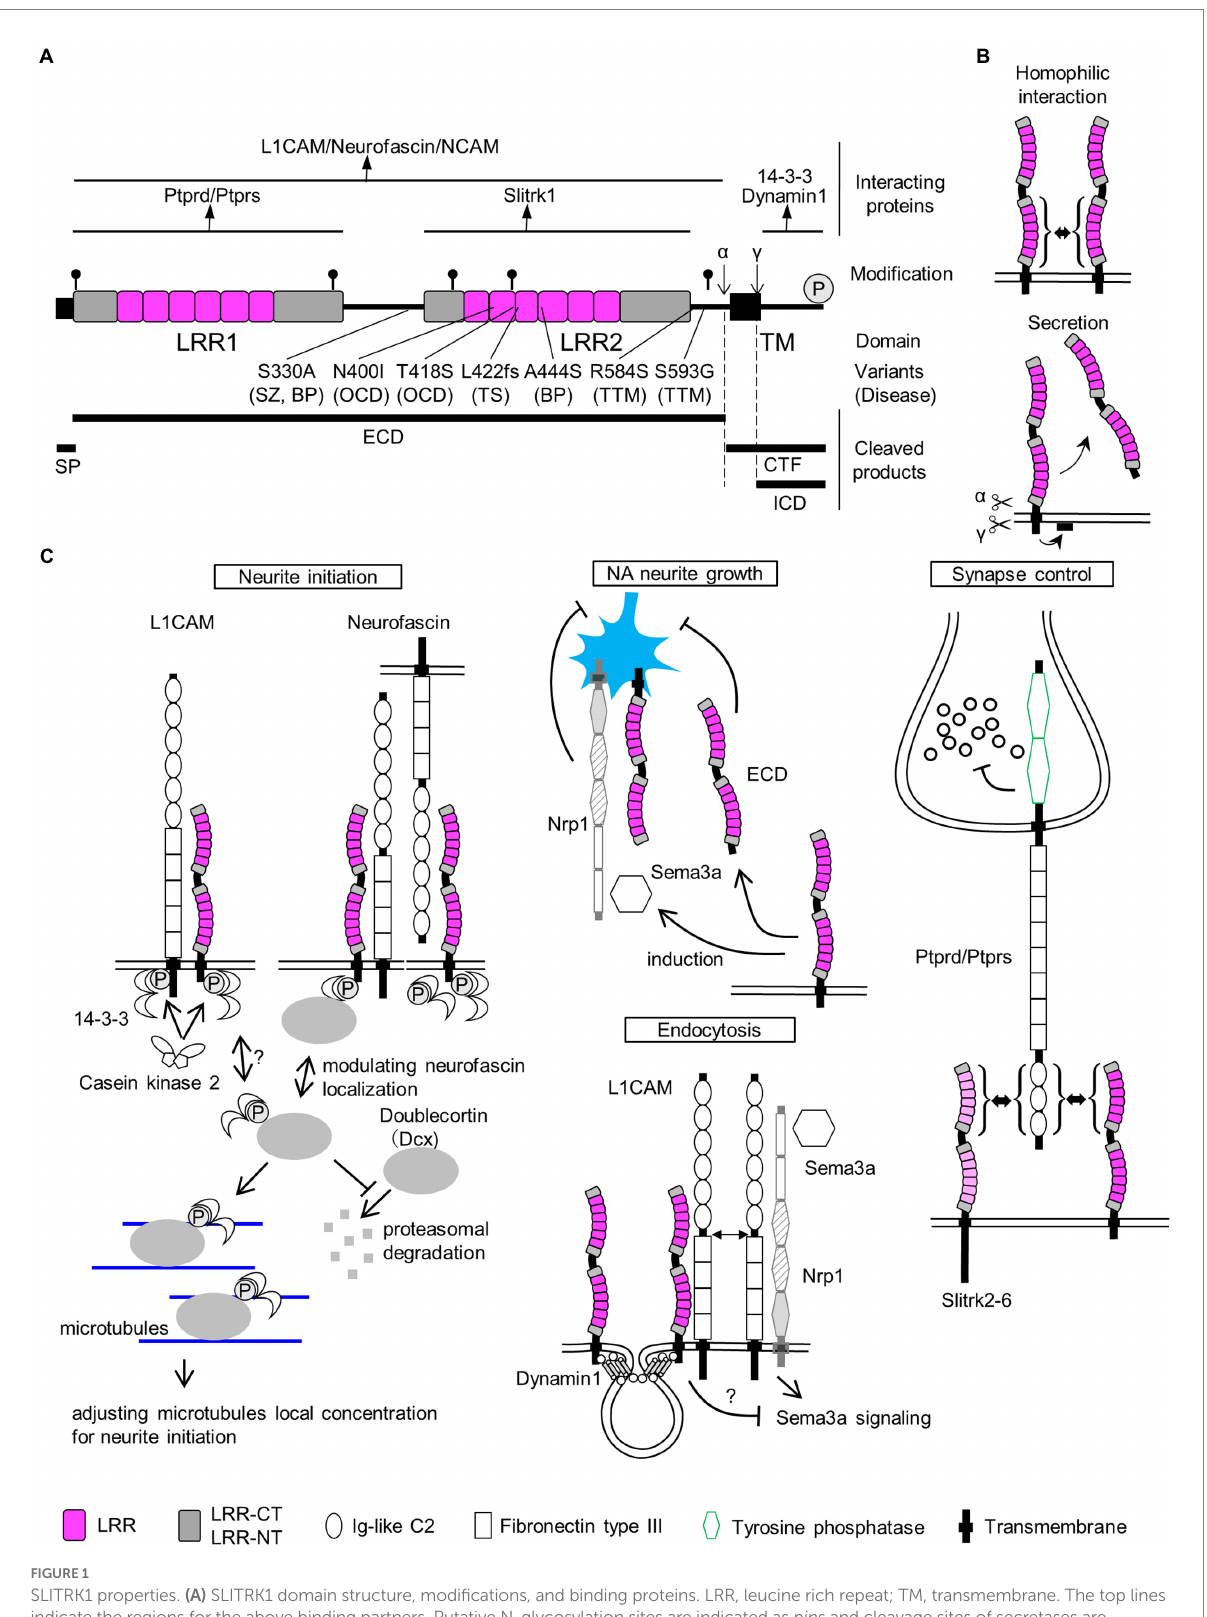
FIGURE 1 SLITRK1 properties. (A) SLITRK1 domain structure, modifications, and binding proteins. LRR, leucine rich repeat; TM, transmembrane. The top lines indicate the regions for the above binding partners. Putative N-glycosylation sites are indicated as pins and cleavage sites of secretases are indicated as α and γ , respectively. The phosphorylation site is indicated as circled P . Variants, changes in amino acid residues of SLITRK1